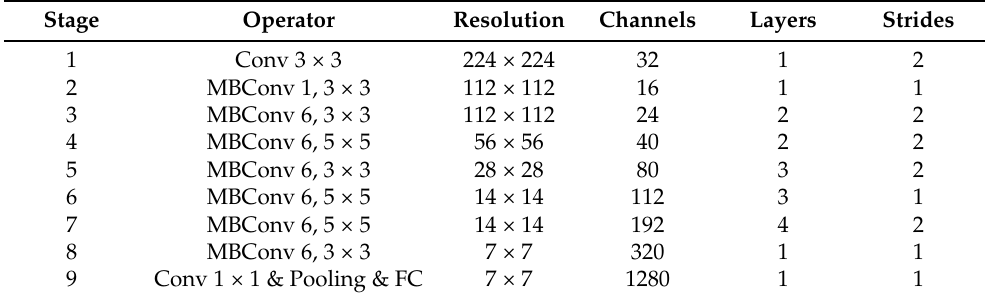
Table 1. Network structure of